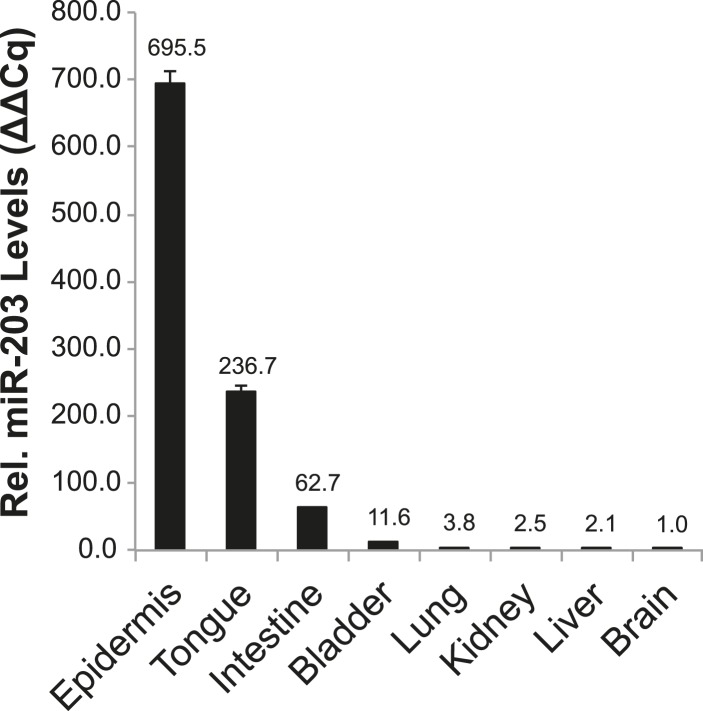
miR-203 expression in diverse mouse tissues.qPCR detection of mature miR-203 in various adult mouse organ tissues. Error bars represent S.E.M from reactions performed in technical duplicate.